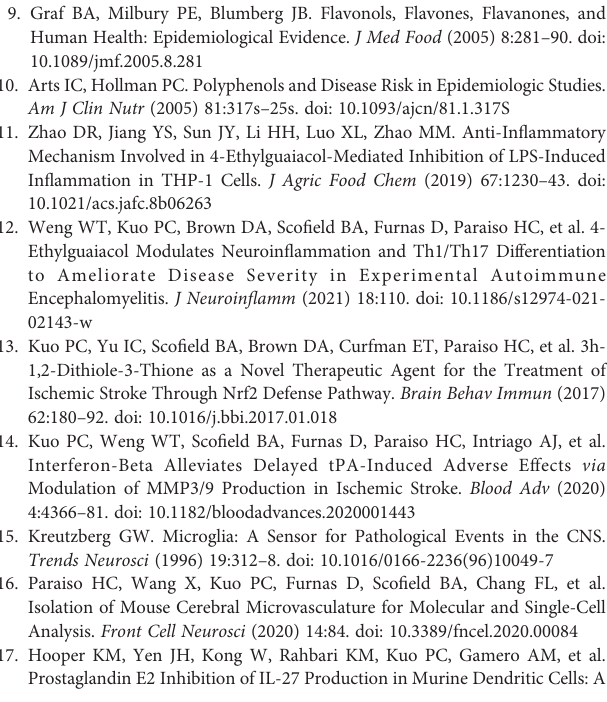
Supplementary Figure 4 | Gating strategy of fl ow cytometry analysis in vitro. MG, BV2, and macrophages (M F ) were subjected to surface staining of CD11b in the presence of 7-AAD followed by intracellular staining of HO-1. 7-AAD negative live cells were gated followed by singlet gating. Isotype controls (Iso) were used as negative controls to determine CD11b + cells positive for the expression of HO-1. Supplementary Figure 5 | 4-EG-induced HO-1 expression in MG is abolished in Nrf2 -/- MCAO mice. Nrf2 -/- male mice were subjected to 40 min MCAO followed by vehicle or 4-EG (100 mg/kg) i.v. administration at 2 h post-reperfusion (n=8/group). At 16-20 h post-injury, the contralateral and ipsilateral hemispheres of vehicle- and 4-EG-treated Nrf2 -/- MCAO mice were harvested followed by mononuclear cell isolation. The isolated mononuclear cells were subjected to surface staining of CD45and CD11band then intracellular staining ofHO-1 followed by fl owcytometry analysis. Isotype controls (Iso) were used as a negative control to determine CD45 int CD11b + MG positive for HO-1 expression. The frequency of HO-1 expression in CD45 int CD11b + MG was measured. ** p < 0.01; *** p < 0.001 , N.S; no signi fi cant differences by one-way